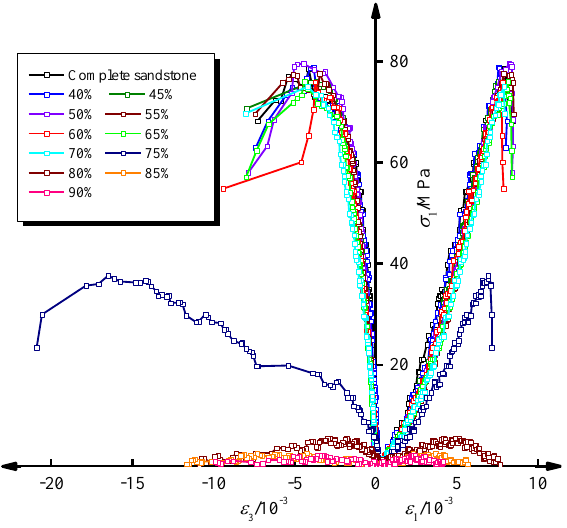
Figure 3. Uniaxial reload stress – strain curve of damaged sandstone.